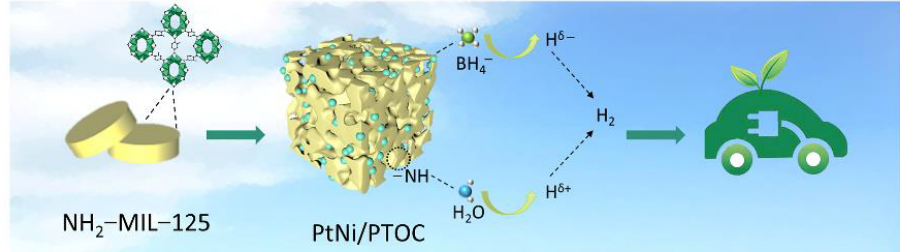
Figure 1. The illustration of the synthetic route of PtNi/PTOC.